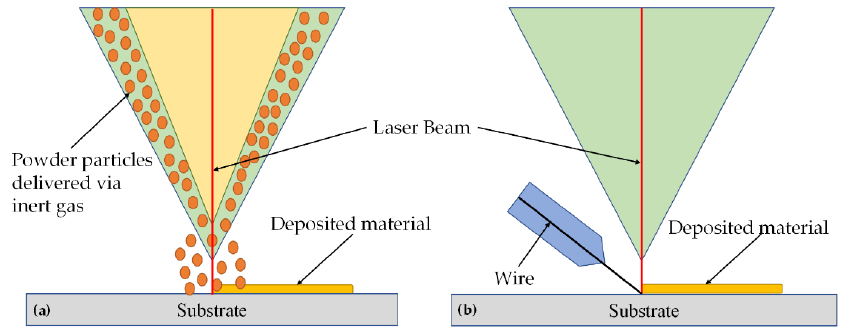
Figure 7. The LMD process: ( a ) coaxial powder feeding and ( b ) lateral wire feeding; based on the data provided in Ref. [92].